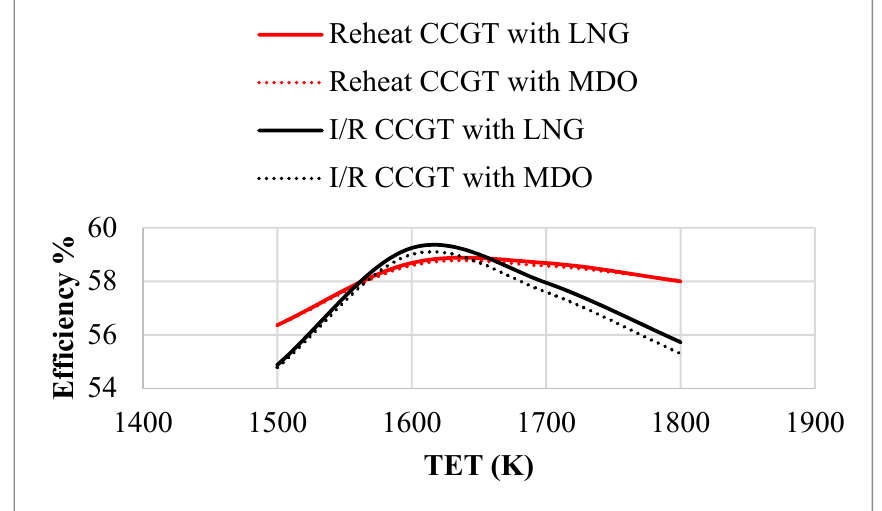
Figure 10. Effect of the TET on the overall thermal efficiency.